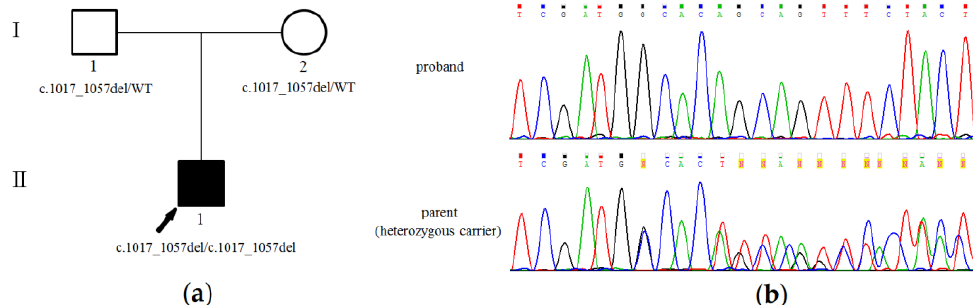
Figure 1. Family tree and genetic testing of the proband with a variant in USP53 : ( a ) Family tree showing the affected proband and unaffected parents; ( b ) Sanger sequencing results demonstrating c.1017_1057del truncating USP53 variant in the homozygous state in the proband and in the heterozygous state in both parents.